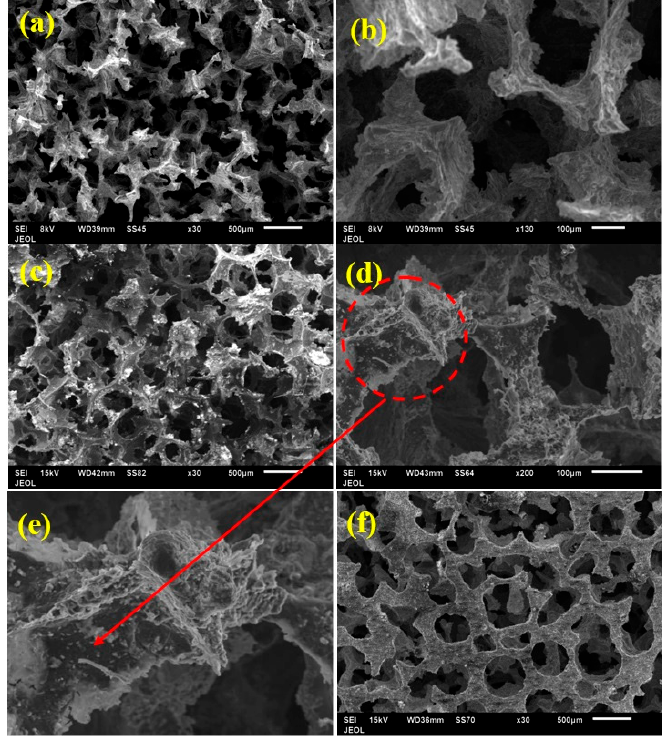
Figure 4. Microstructures of ( a , b ) the pure Al foam at different magnifications; ( c,d ) the Al-SiC foam at different magnifications; ( e ) a magnified area selected from ( d ); and ( f ) the pure Mg foam.